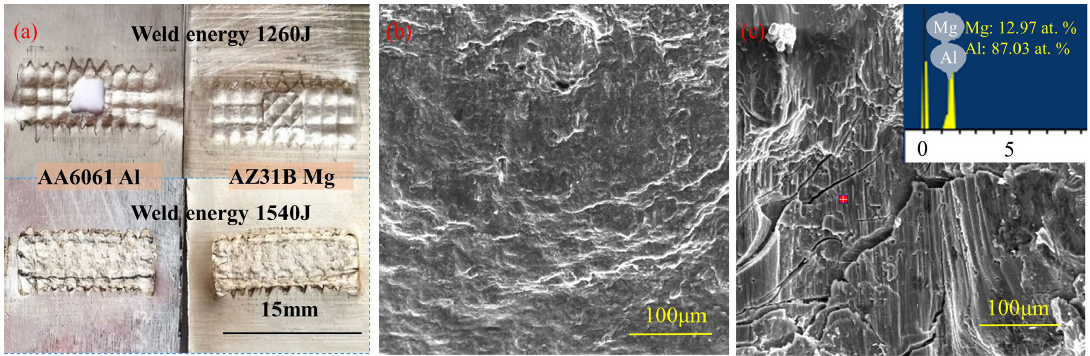
Figure 10. The failure behaviour (a) and fracture morphology of the welded metal (b) 980 J (c) 1540